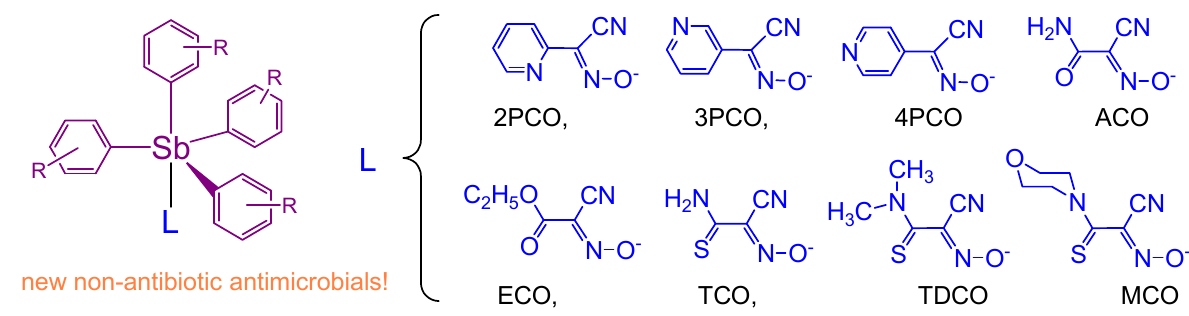
Table of content picture(General formula for the first series of new non-antibiotic